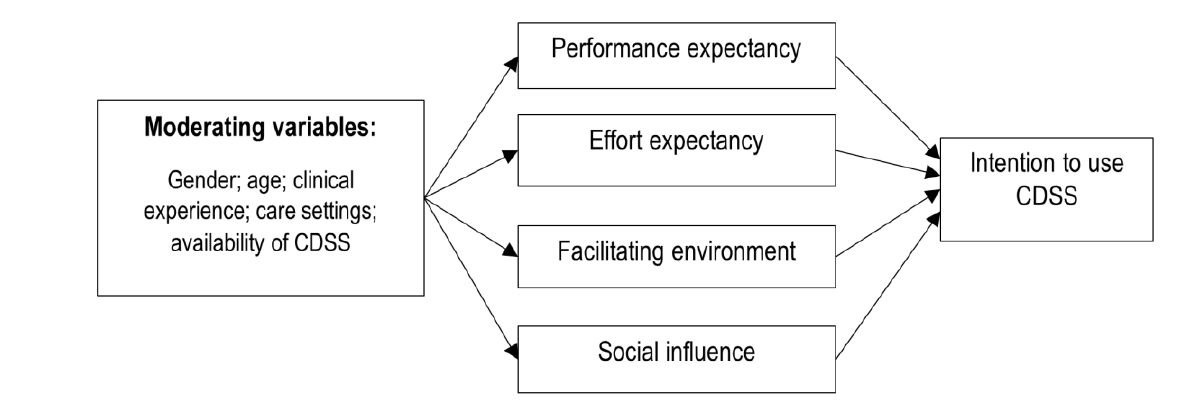
Figure 1. Theoretical framework of the study, the unified theory of acceptance and use of technology (UTAUT) model .